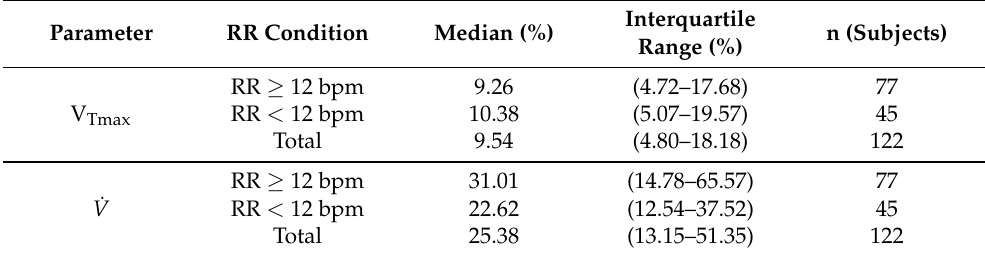
Table 4. Tabulated errors between experimental and predicted data for the “Anatomy and Physiol- ogy” module.